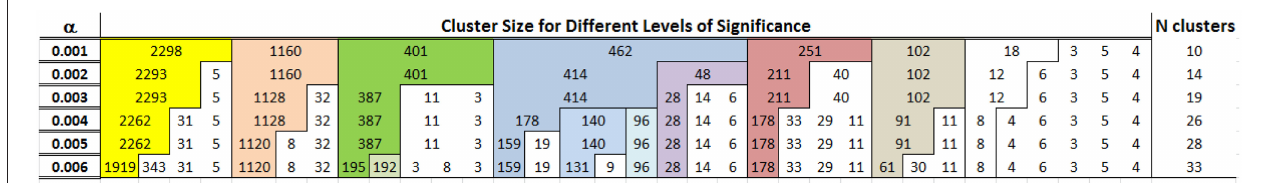
0.001, and the = 0.002, and the 2298 profiles are =